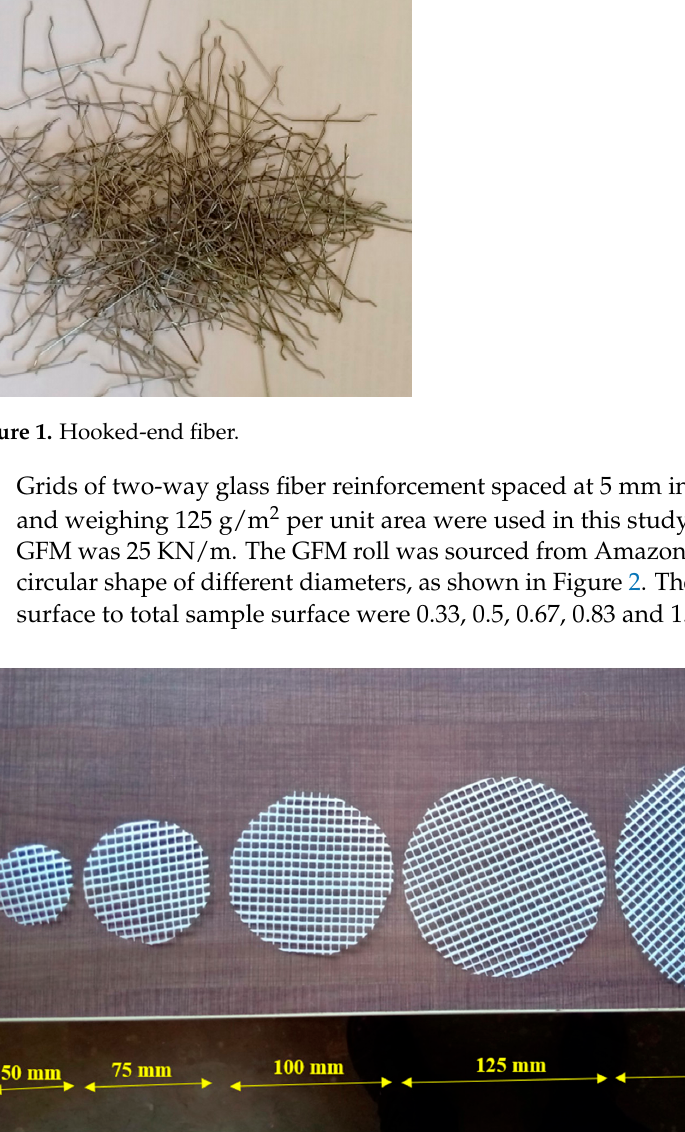
Figure 2. GFM with varying